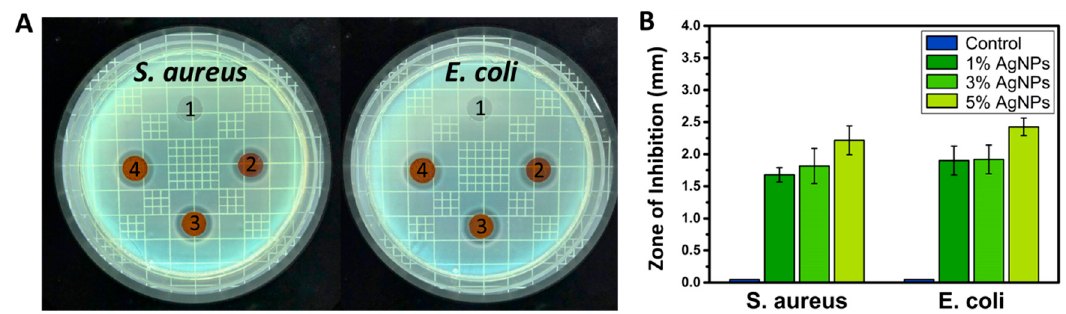
Figure 4. ( A ) Digital images and ( B ) zone of inhibition for antibacterial effect of PU films containing 0%, 1%, 3%, and 5% of AgNPs against Staphylococcus aureus and Escherichia coli .